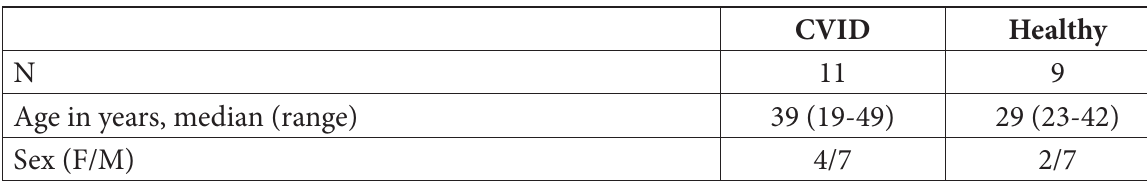
Table 1. Demographic characteristics of the study